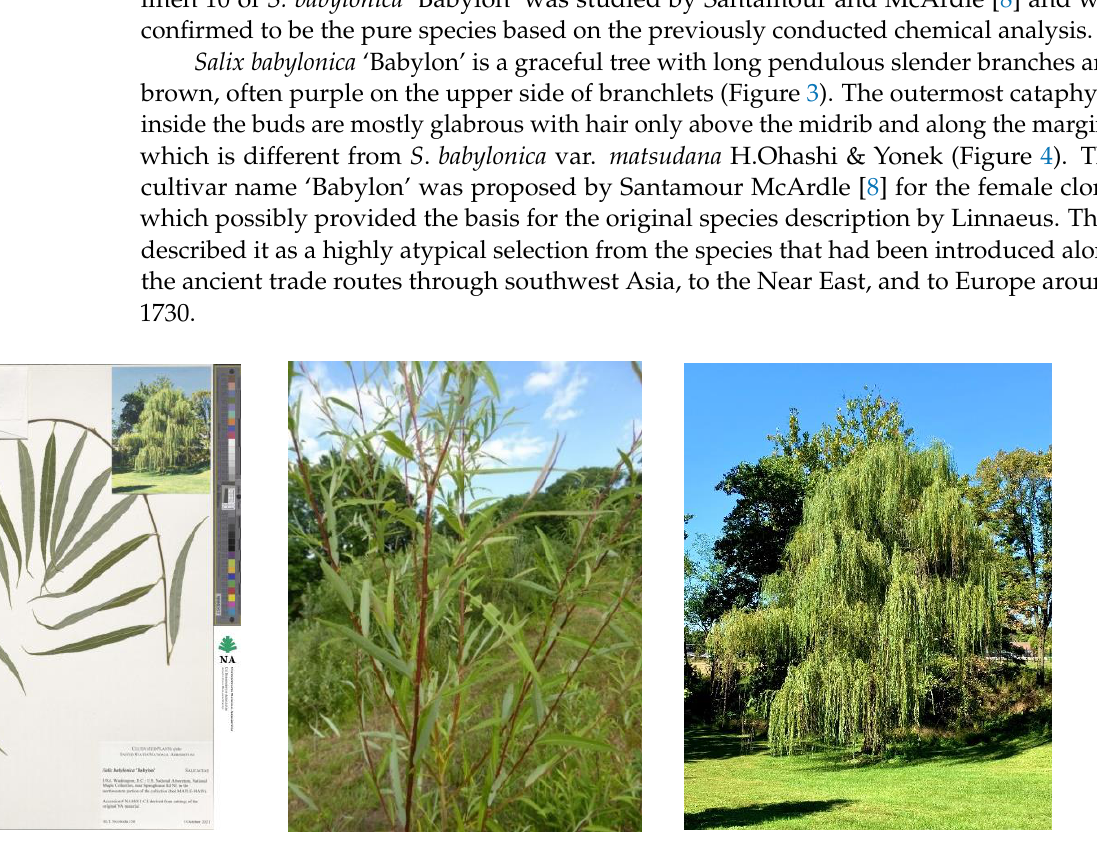
Figure 3. Herbarium specimen of S. babylonica ‘Babylon’ (NA0263746) of the live specimen NA44011 ( left ). The green-brown bark of branches of S. babylonica ‘Babylon’ NA44011 growing at Storrs, Connecticut, US, gets tanned, gaining purple color on the upper side exposed to the sun ( center ). S. babylonica ‘Babylon’ NA44011 growing at the National Arboretum, Washington, US, displays its strongly pendulous habit ( right ) (photo by H. Svoboda).